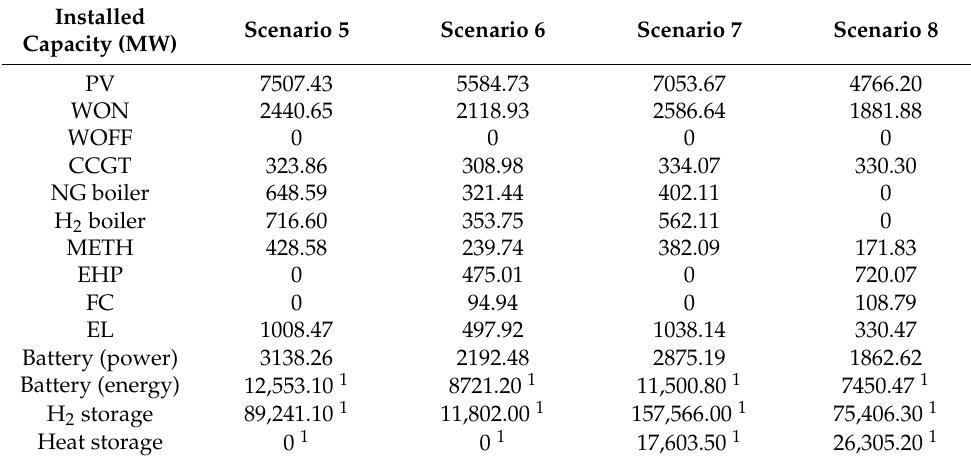
Table 4. Results of the case study: installed capacities for scenarios 5 to